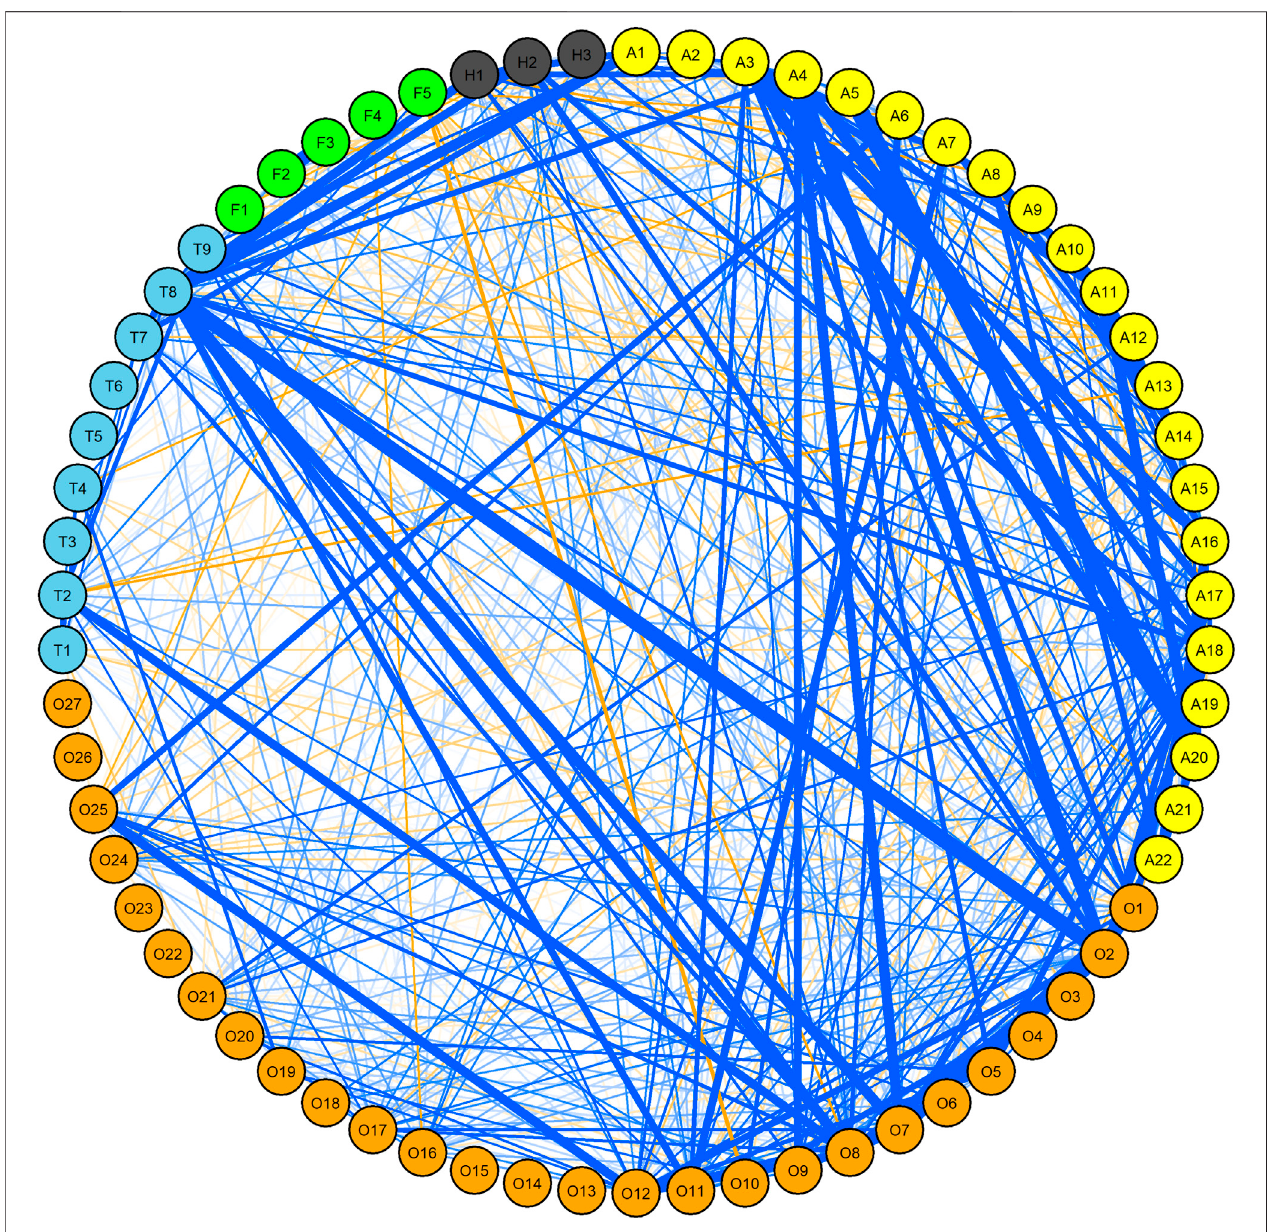
FIGURE 1 | Correlation network among yellow wheat blossom midge (yellow), orange wheat blossom midge (orange), thrip (skyblue), frit fl y (green) and seed gall midge (dark gray) in winter wheat (WW) panel. Only correlations > 0.1 R2 and signi fi cant at at least 0.05 p -values are shown. Blue and orange lines indicate positive and negative correlations, respectively where the thickness of the line is proportional to the strength of the correlation. For details, see Supplementary Table S1 .